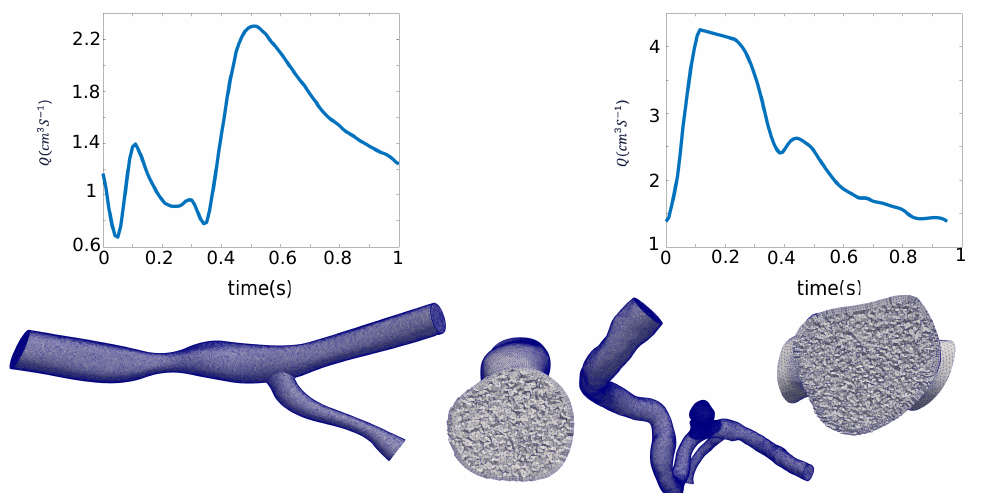
Figure 1. The three-dimensional models, the corresponding mesh, and flow waveforms used as the inlet boundary condition are shown. The left panel shows the coronary artery stenosis model and the right panel shows the cerebral aneurysm